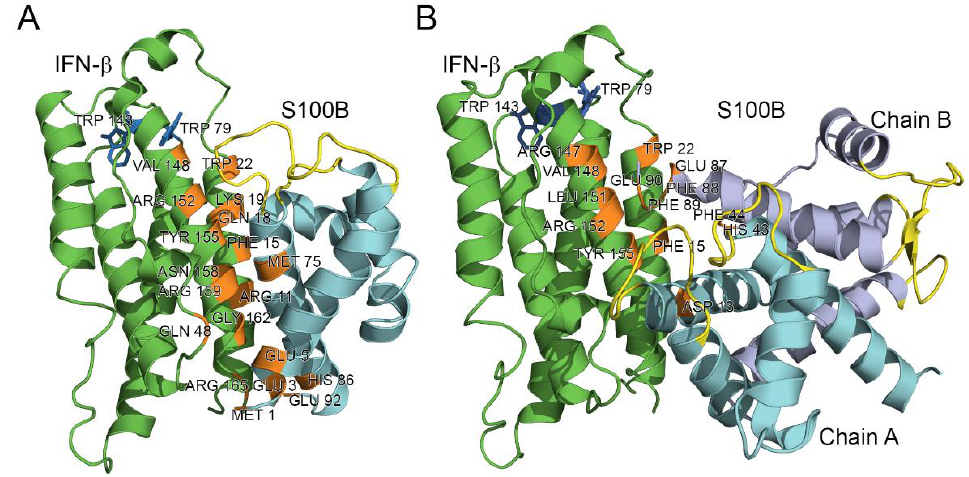
Figure 6. The models of tertiary structures of IFN- β (shown in green) bound to Ca 2+ -loaded S100B monomer ( A ) or dimer ( B ). Crystal structures of IFN- β and Ca 2+ -loaded S100B dimer (PDB entries 1AU1 and 5D7F, respectively) are used for the modeling by ClusPro docking server [61]. The model of S100B monomer is built using I-TASSER server [62]. The Ca 2+ -binding loops are shown in yellow. The numbering of the contact residues (orange-colored) is according to the PDB entries.